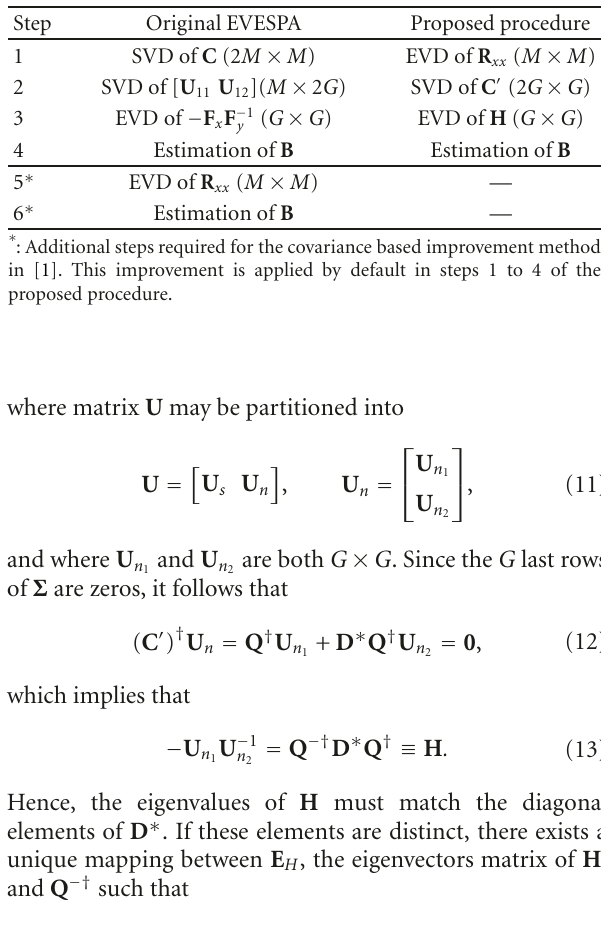
Table 1: Summary of the main computational steps involved in the original EVESPA and the proposed estimation procedure.